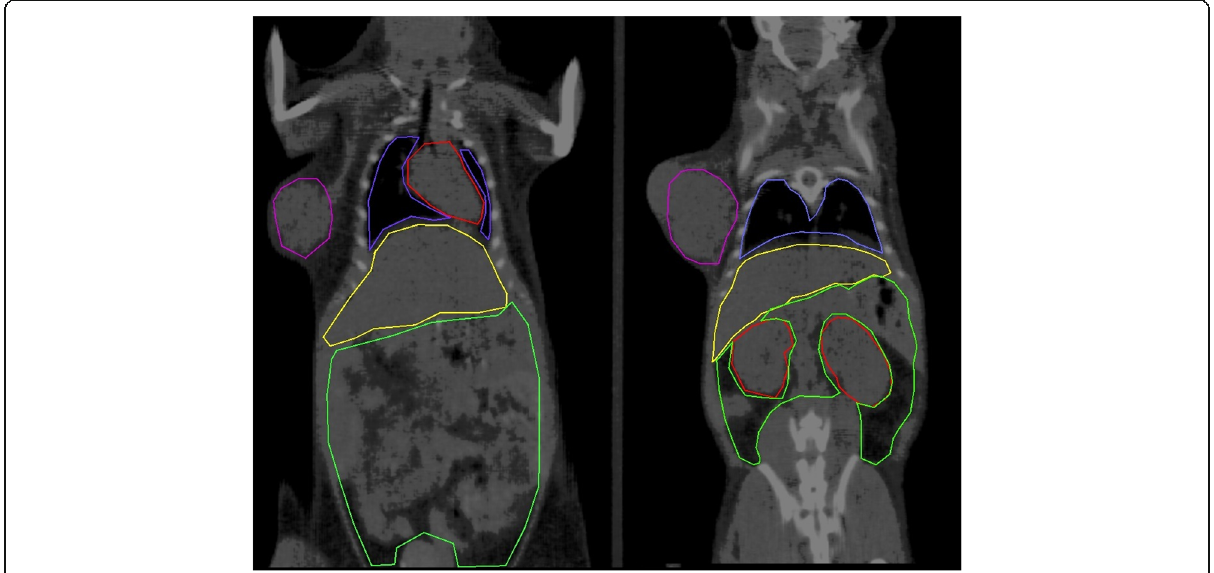
Fig. 2 Example of manual CT-based segmentation of most relevant thoracic (heart, lungs) and abdominal organs (liver, kidneys, and intestines), along with a subcutaneous tumor on the right